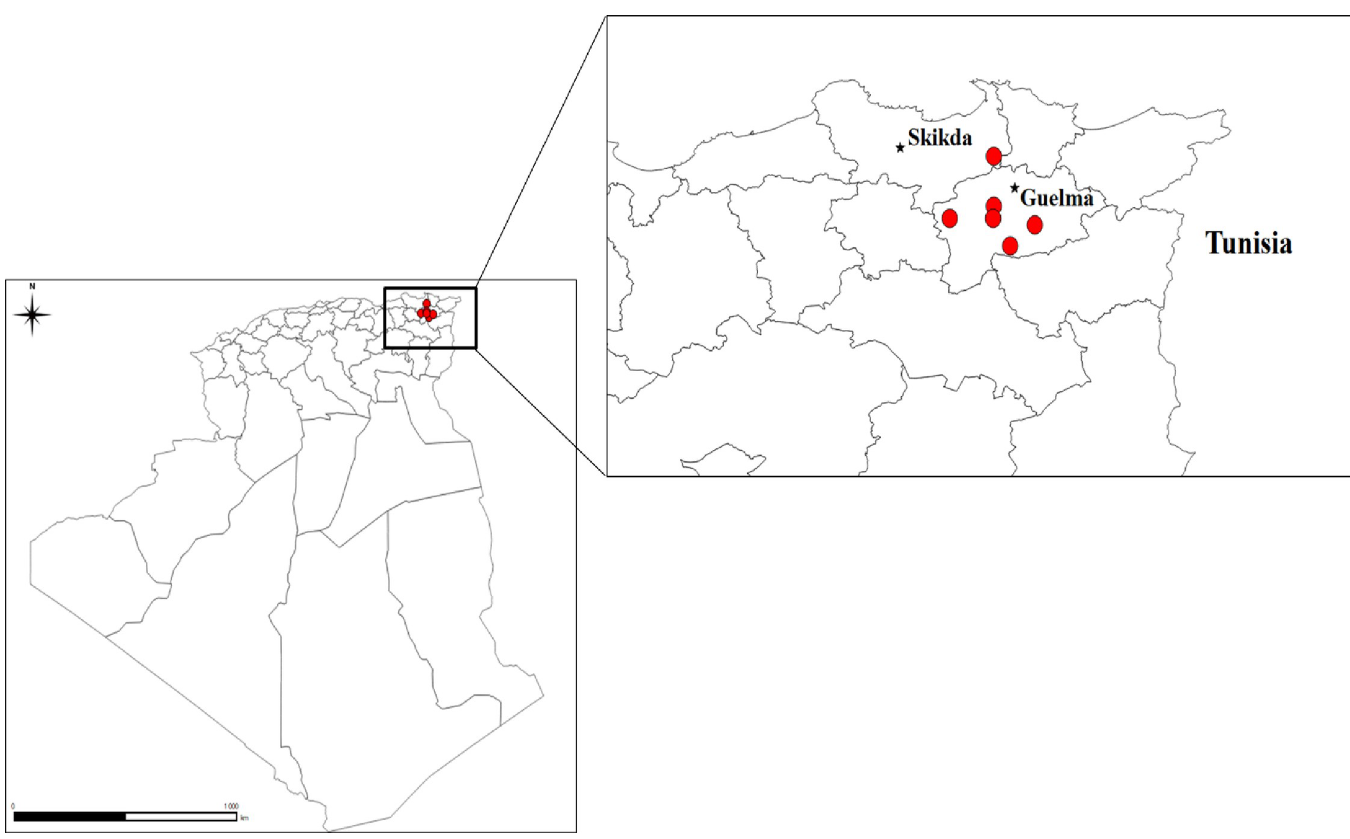
Fig 1. Study area. Map of Guelma (Algeria) showing the locations of the municipalities investigated. Map created using the Free and Open Source QGIS.